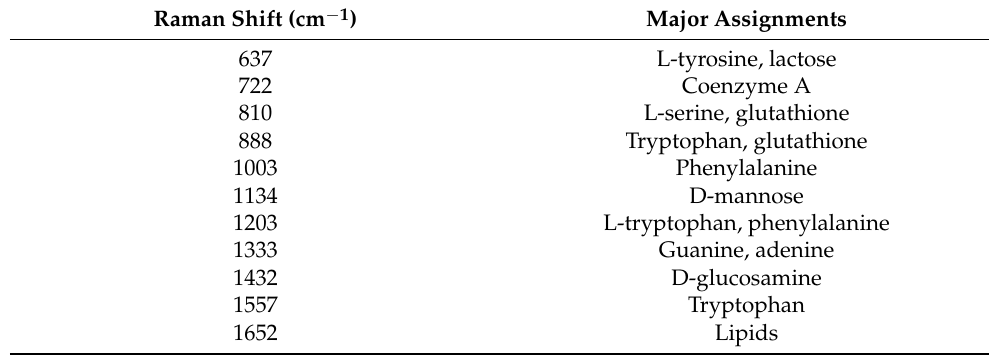
Figure 2. ( a ) Comparison of average SERS spectra of a GB stone and GB polyp patients, ( b ) GB stone and Healthy objects, ( c ) GB polyp and Healthy objects. The shaded areas represent the standard deviations of the means. In addition shown at the bottom is the difference spectrum. ( d ) The corresponding histograms of the average intensities and standard deviations of SERS peaks among the three groups. * p < 0.05. Table 2. Tentative assignments of main peaks observed in SERS spectra of serum samples according to the literature.